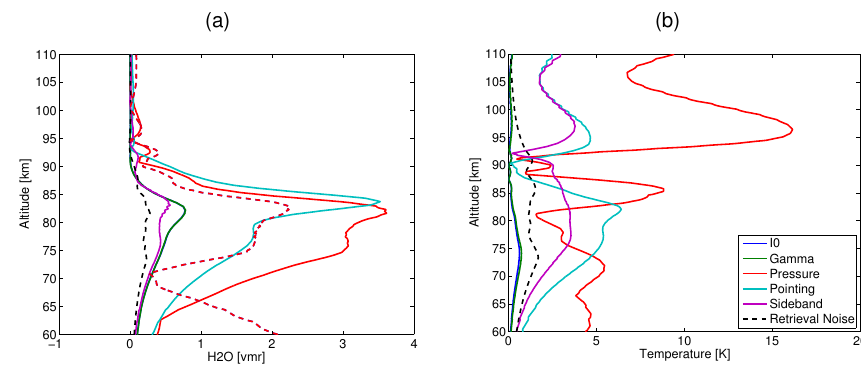
Figure 11. Estimated uncertainties for water vapour (a) and temperature (b) from the tomographic retrievals. The dashed black line shows the estimated retrieval noise. The solid lines show the errors due to forward model parameters. Finally, the dashed red line shows the uncertainty arising from errors in the background pressure, if number densities are used as the retrieved quantity. For a complete description of the parameters see the